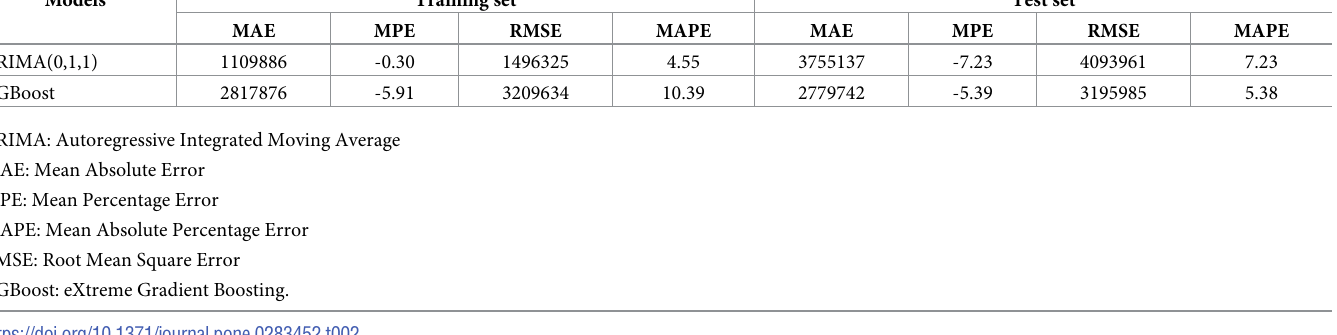
Table 2. Evaluation of parameters for the ARIMA and XGBoost model for rice production in Bangladesh. Models Training set Test set MAE MPE RMSE MAPE MAE RMSE MAPE